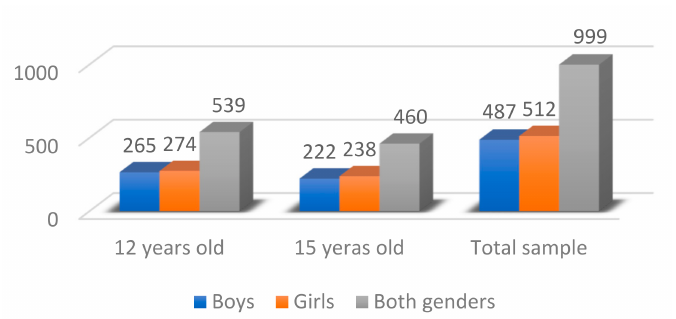
Figure 1. Valid sample distribution by age and gender.